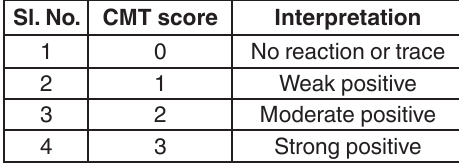
table 1 . Interpretation of CMT